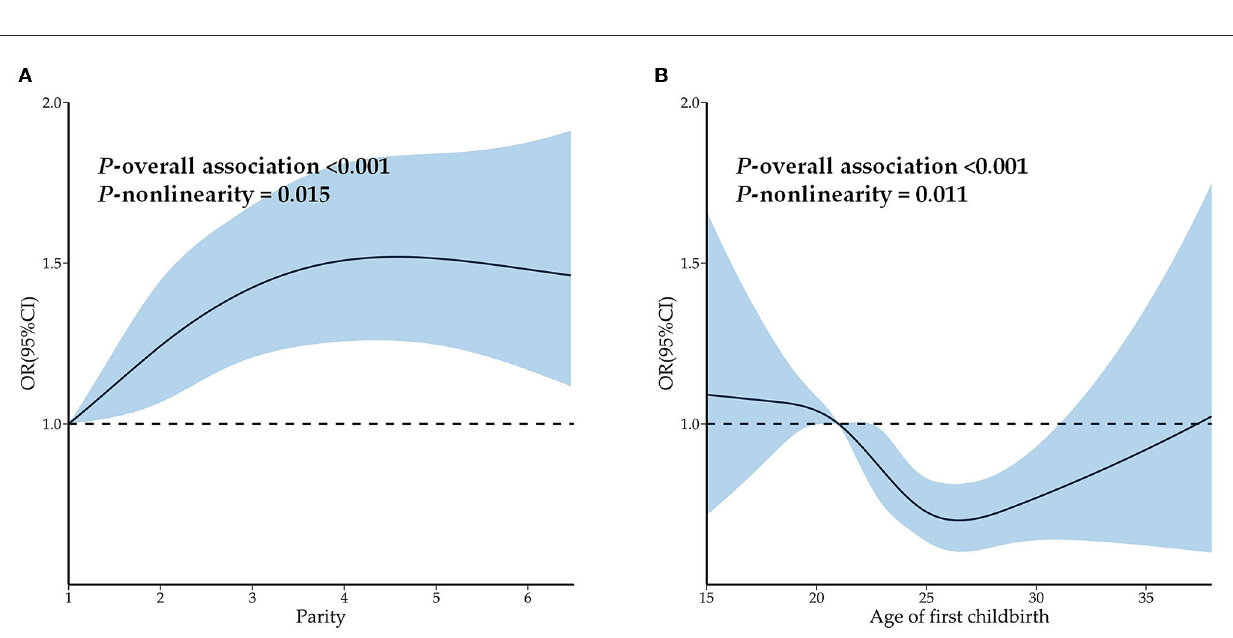
With the acceleration of the aging process, middle-aged and elderly women in China are experiencing an unprecedented burden of multimorbidity, with a prevalence rate of 58.6% in